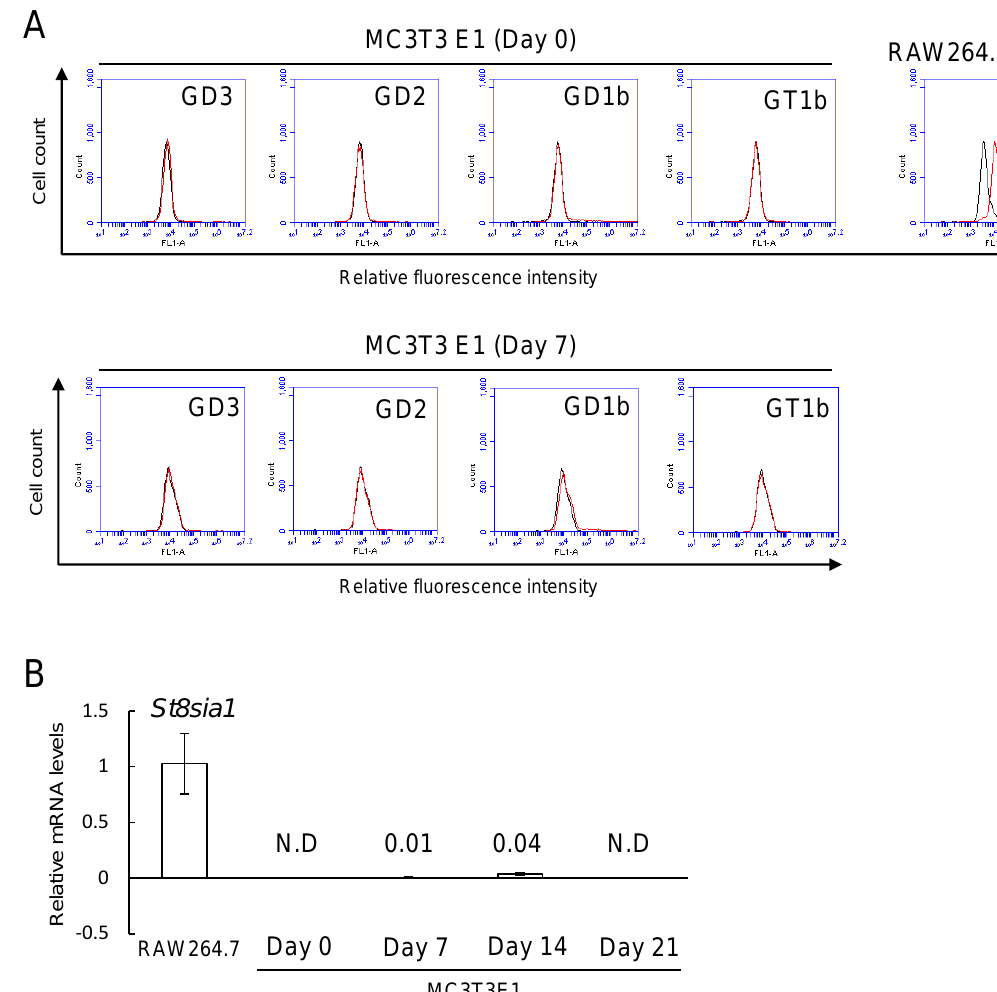
Figure 2. No detection of b-series gangliosides (GD3, GD2, GD1b, and GT1b) and GD3